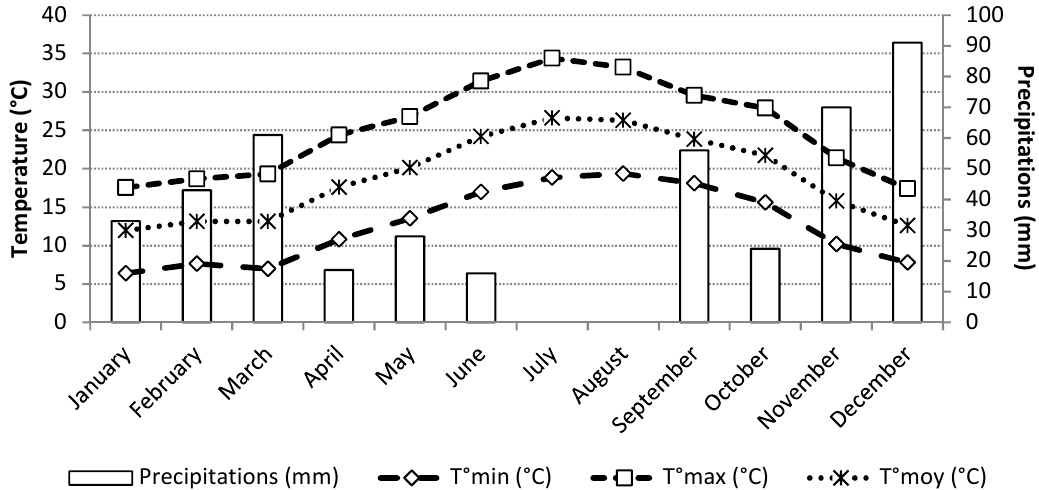
Figure 1. Monthly averages of maximum and minimum air temperatures and cumulative precipitations registered during the year of the essays (Technical Center of Potato and Artichoke meteorological station, Manouba, Tunisia).